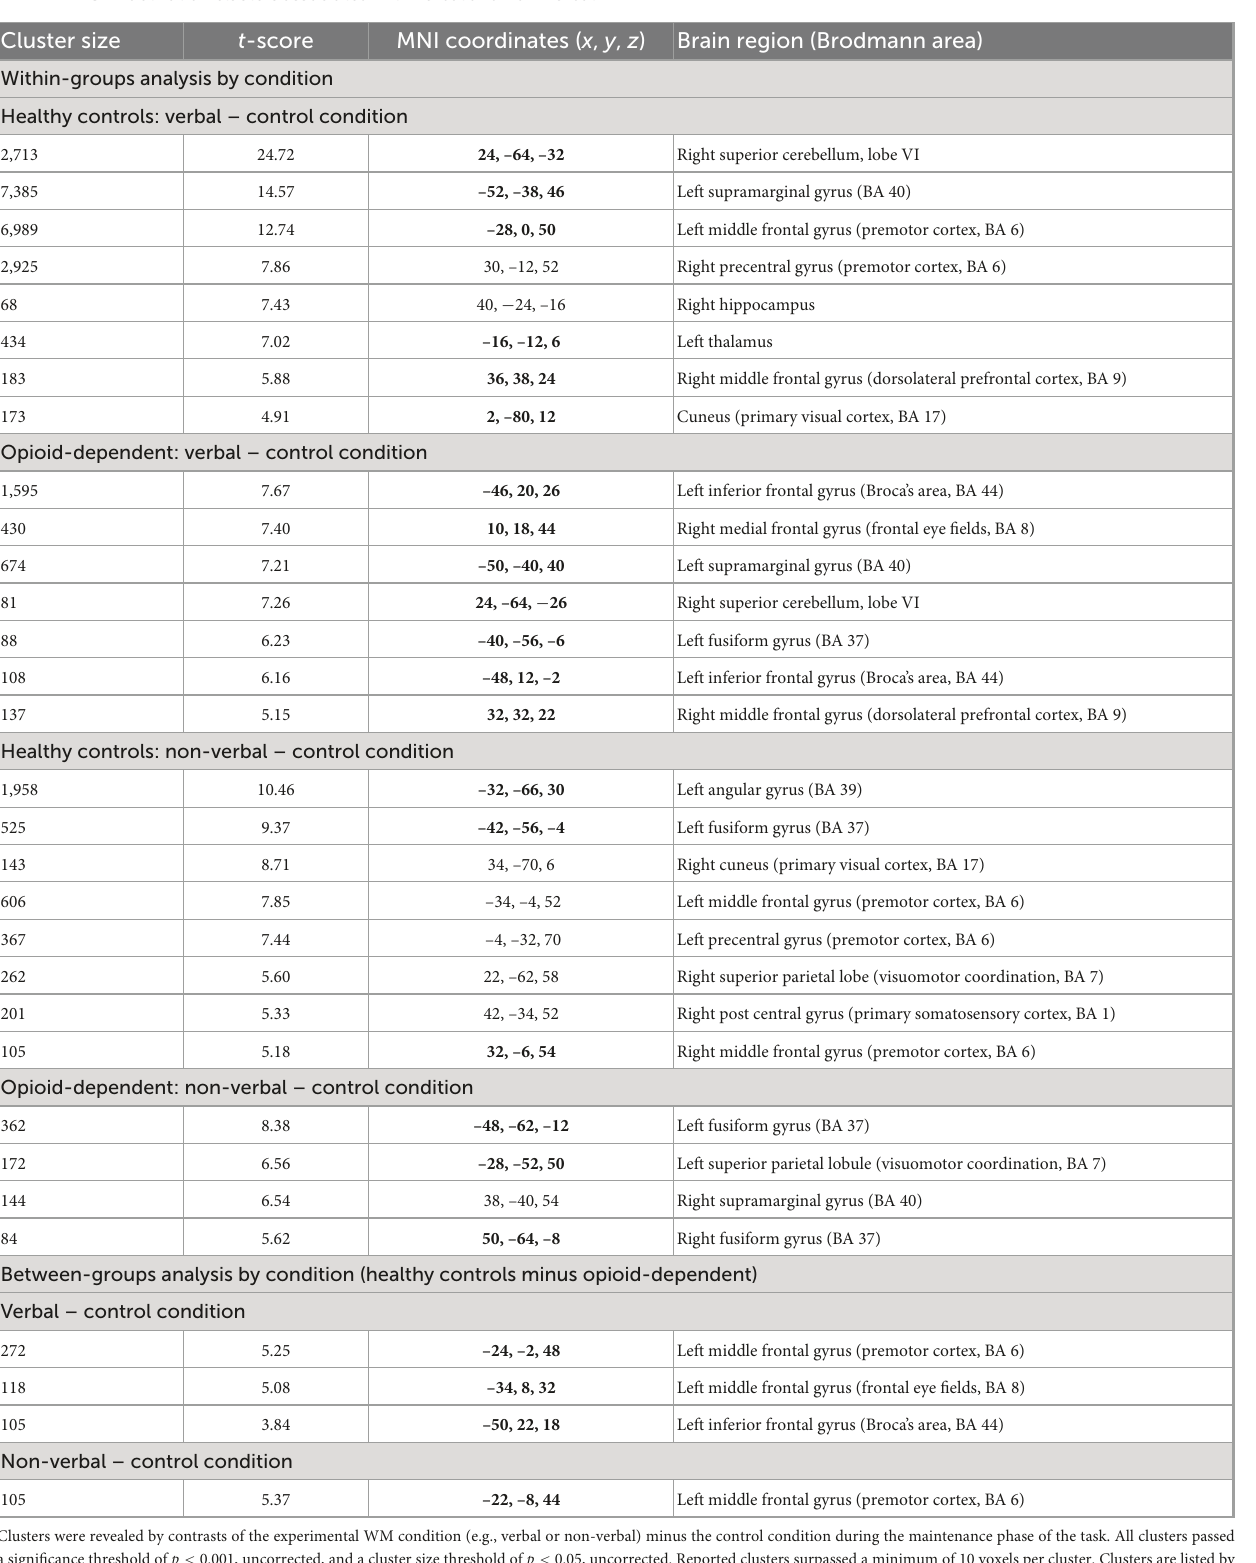
Clusters were revealed by contrasts of the experimental WM condition (e.g., verbal or non-verbal) minus the control condition during the maintenance phase of the task. All clusters passed a significance threshold of p < 0.001, uncorrected, and a cluster size threshold of p < 0.05, uncorrected. Reported clusters surpassed a minimum of 10 voxels per cluster. Clusters are listed by decreasing t -scoreofthepeakvoxelwithinacluster.BoldedregionsofinterestreflectconsistencywithpreviousWMimagingstudies(PollmannandVonCramon,2000;ChenandDesmond, 2005;ChampodandPetrides,2007;MarvelandDesmond,2012;Marveletal.,2012,2019,2022;Liaoetal.,2014;Sobczak-Edmansetal.,2016).CoordinatesarelistedaccordingtotheMontreal Neurological Institute (MNI) atlas within SPM12. MNI coordinates were converted to Talairach using the MNI2TAL function within the BioImage Suite Web (https://bioimagesuiteweb. github.io/webapp/#), which includes a Brodmann area (BA) overlay, and then cross-referenced against the Talairach atlas (Talairach and Tournoux, 1988). Note that clusters revealed by the